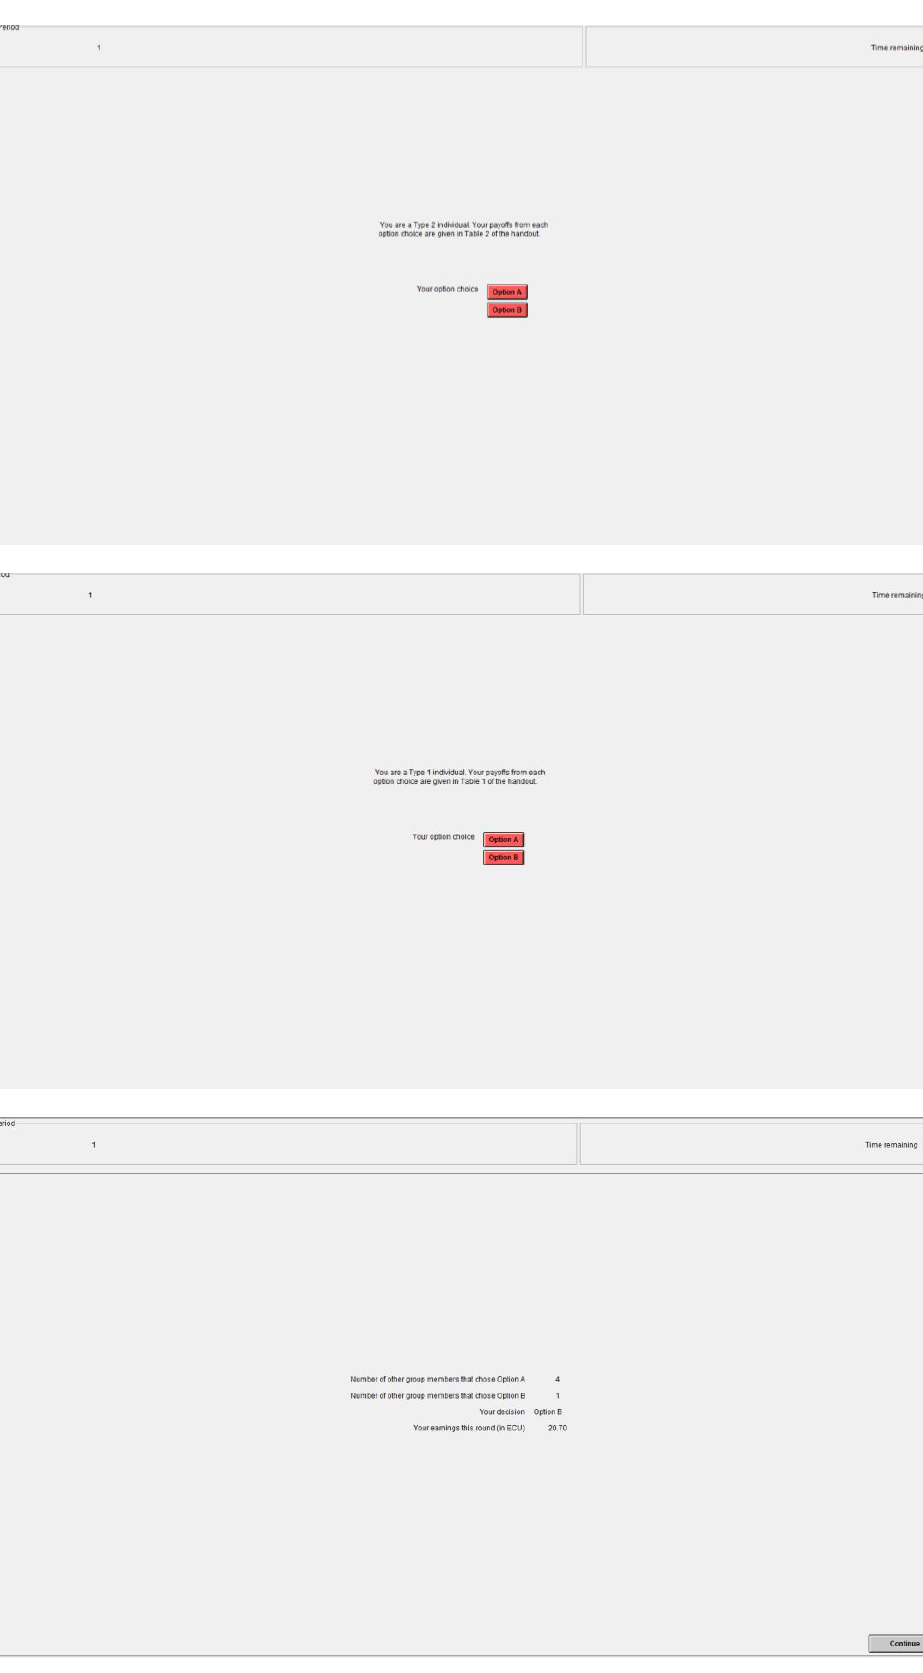
Figure A1. Experimental instructions (screen shots).